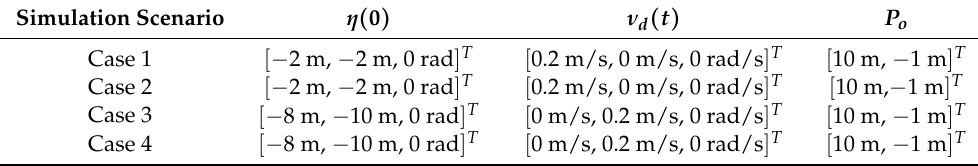
Figure 3. The distances between dynamic positioning vessel and obstacle under four cases. Table 1. Design